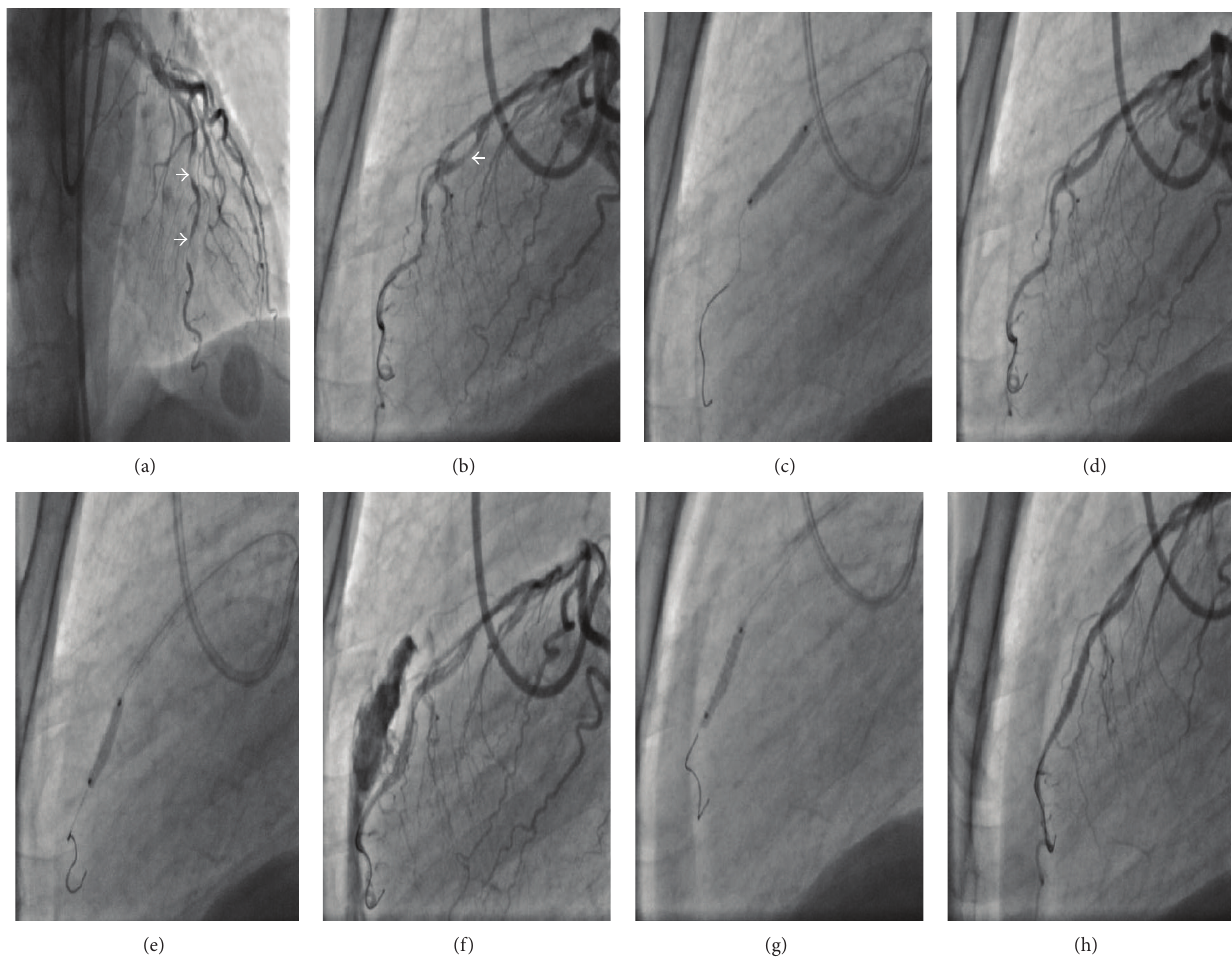
Figure 1: ((a)-(b)) Coronary angiography images of the patient in anterior-posterior cranial and lateral views which show myocardial bridges causing severe compression and near complete occlusion of the middle and distal segments of the LAD during systole, marked by arrows. ((c)-(d)) A drug eluting stent deployment at the middle segment of the LAD in lateral view. ((e)-(f)) During stenting of the distal segment of the LAD, coronary artery perforation occurred and massive blood flow extravasating into the pericardial space. ((g)-(h)) A polytetrafluoroethylene-covered stent was deployed over the perforation site, and this successfully sealed the perforation. LAD: left anterior